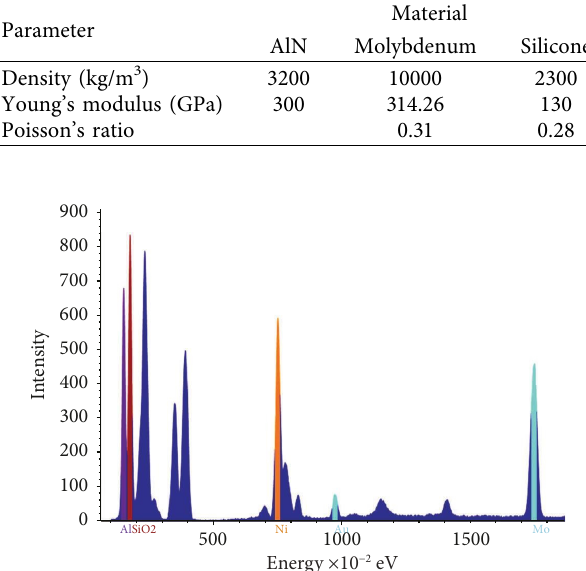
Figure 6: Te energy-dispersive X-ray spectroscopy (EDX) characterization results for AlN area of FBAR sensor surface.